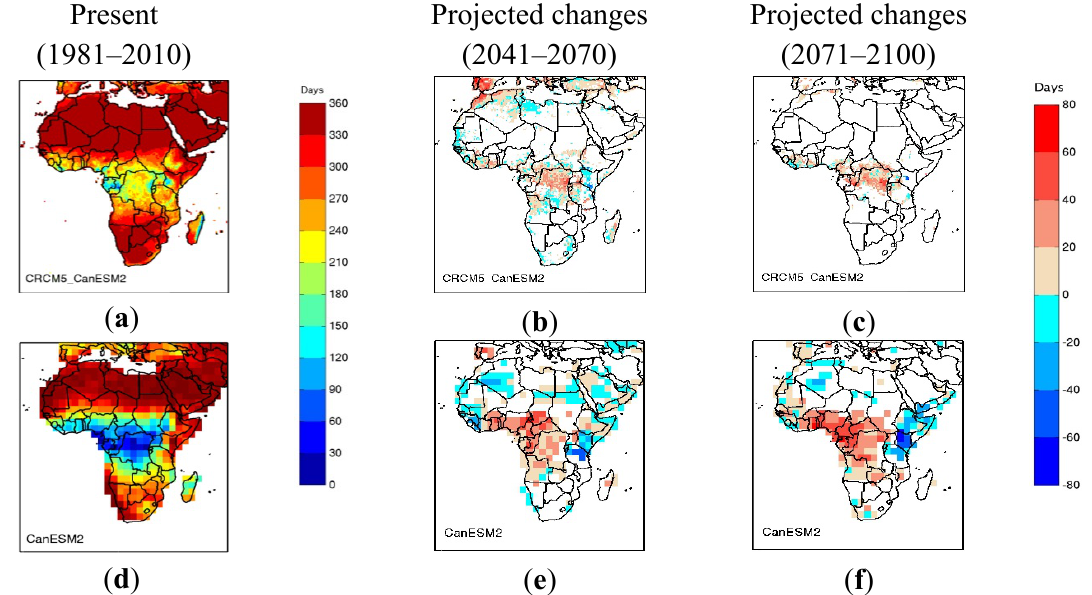
Figure 6. Annual mean number of dry days as simulated by CRCM5 driven by CanESM2 ( a – c ) and CanESM2 ( d – f ) for the present (1981–2010) (a,d) and the corresponding projected changes for the 2041–2070 (b,e) and the 2071–2100 (c,f) periods for RCP 4.5 scenario for 2 mm threshold. Grid cells where projected changes are not statistically significant at 95% confidence level are shown in